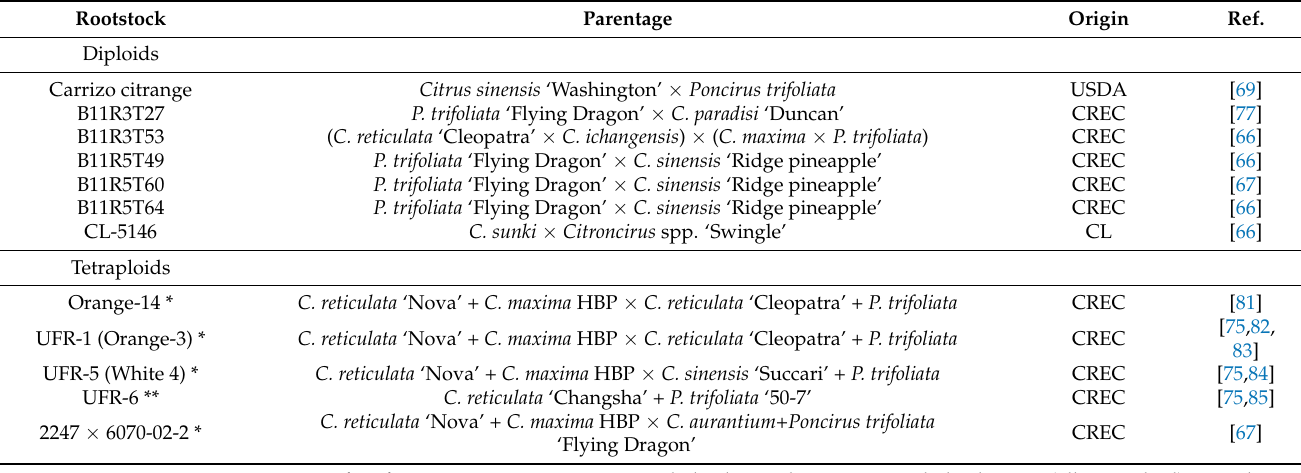
Table 4. Citrus rootstock evaluated against white root rot disease in this